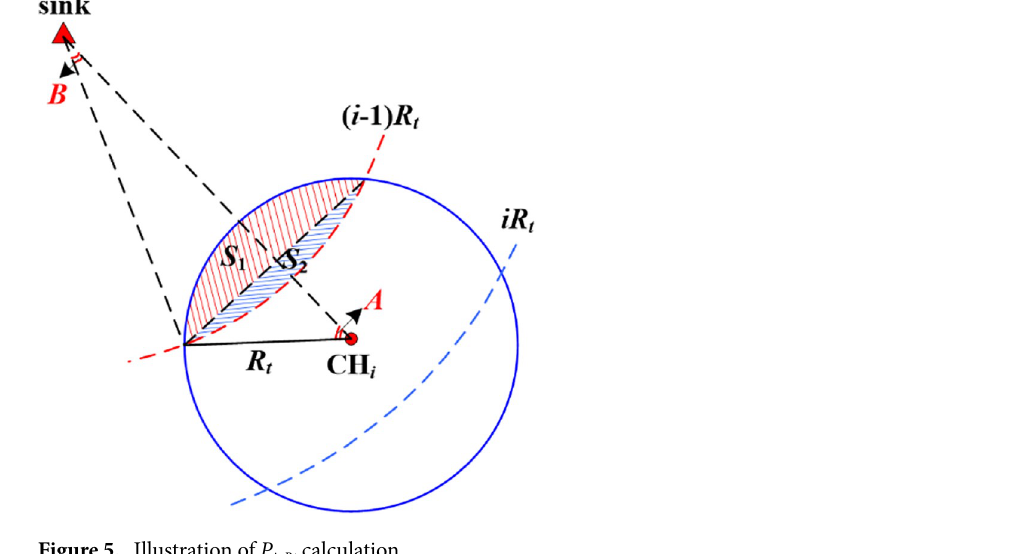
Figure 5. Illustration of P inRt